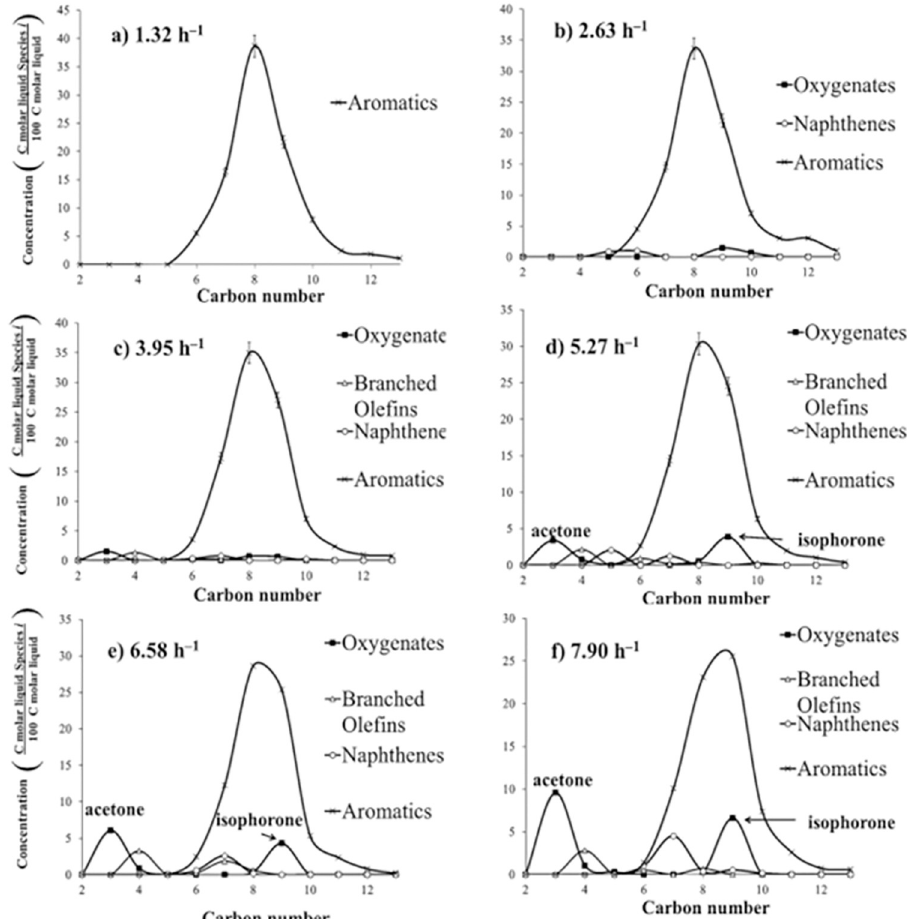
Fig 9. Liquid carbon product distribution of acetone reaction over HZSM-5(80), T = 415˚C, and P = 101 kPa (abs).